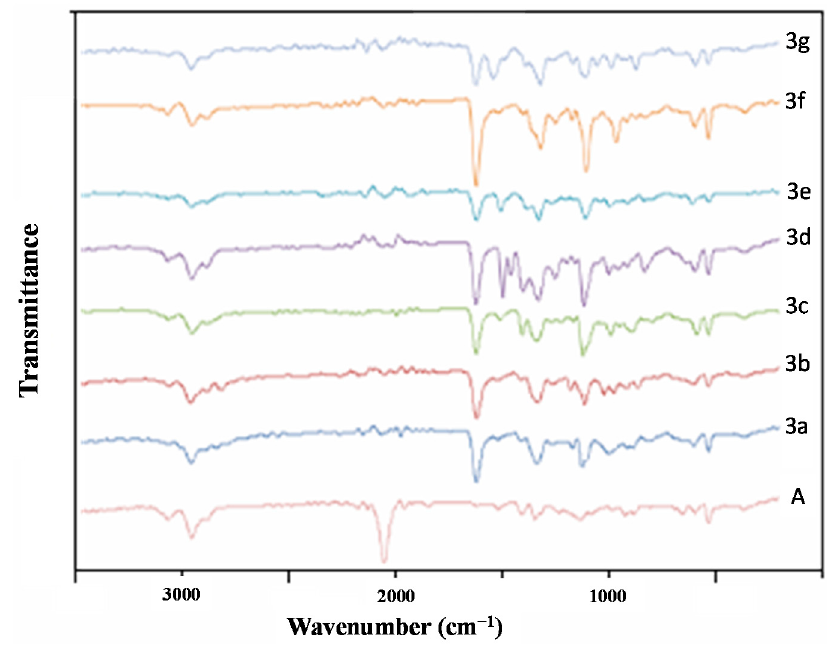
Figure 2. ATR/FTIR spectra of triazolic polymers 3a – g and of the starting azidomethyl polystyrene ( A ). Table 1. Masses, substitution and number of millimoles for 250 mg (incubation scale) of the synthesized polymer-supported triazolic piperazines 3a – g .